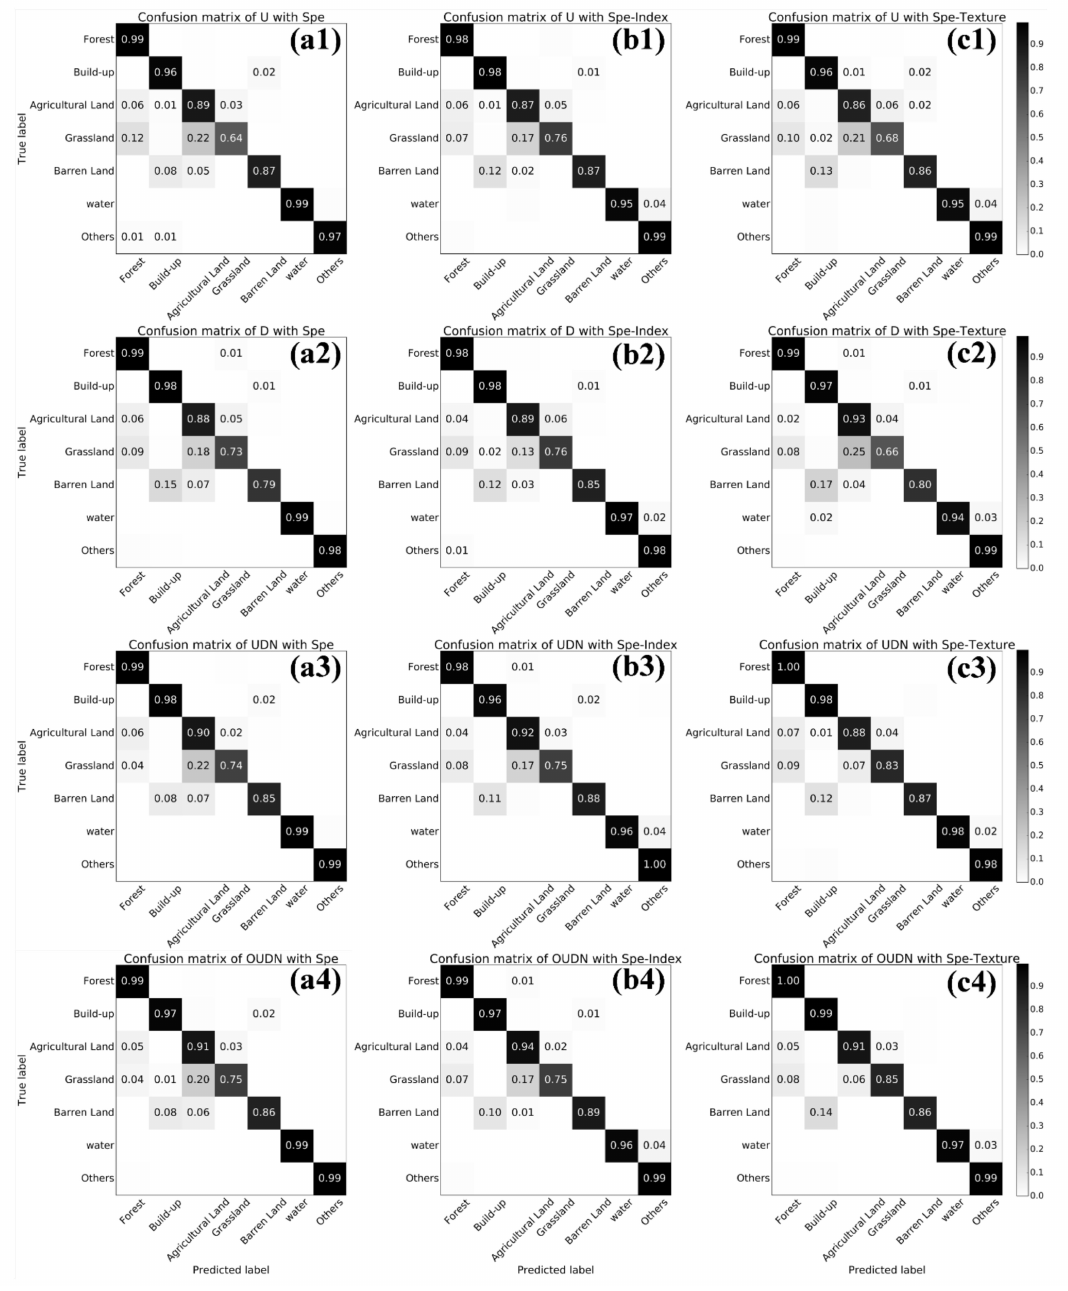
Figure 12. ( a1 ) Confusion matrix of U algorithm based on Spe; ( b1 ) Confusion matrix of U algorithm based on Spe-Index; ( c1 ) Confusion matrix of U algorithm based on Spe-Texture; ( a2 ) Confusion matrix of D algorithm based on Spe; ( b2 ) Confusion matrix of D algorithm based on Spe-Index; ( c2 ) Confusion matrix of D algorithm based on Spe-Texture; ( a3 ) Confusion matrix of UDN algorithm based on Spe; ( b3 ) Confusion matrix of UDN algorithm based on Spe-Index; ( c3 ) Confusion matrix of UDN algorithm based on Spe-Texture; ( a4 ) Confusion matrix of OUDN algorithm based on Spe; ( b4 ) Confusion matrix of OUDN algorithm based on Spe-Index; ( c4 ) Confusion matrix of OUDN algorithm based on